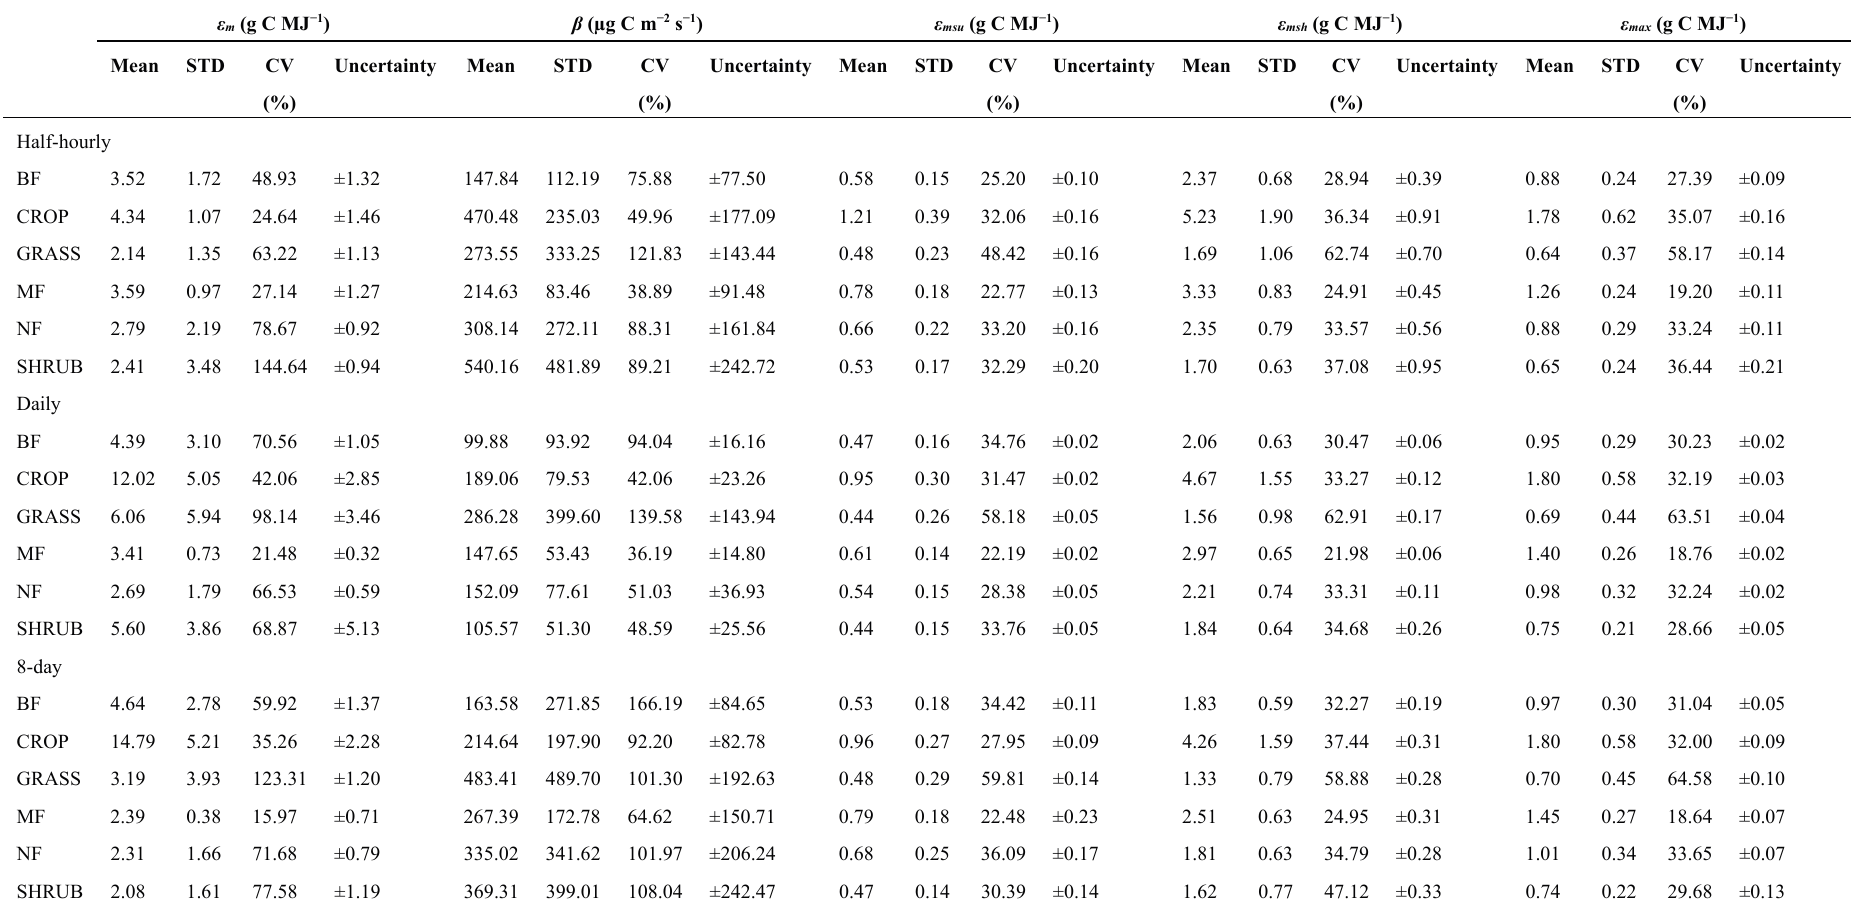
Table 3. Average, standard deviation, variation of coefficient (CV), and uncertainties range of optimized ε m , β , ε msu , ε msh and ε max for 6 different vegetation types at half-hourly, daily and 8-day temporal scales ( ε m , β in TL-LUEn, ε msu , ε msh in TL-LUE, and ε max in MOD17). The uncertainty was quantified with a 95% highest-probability density interval and averaged over each